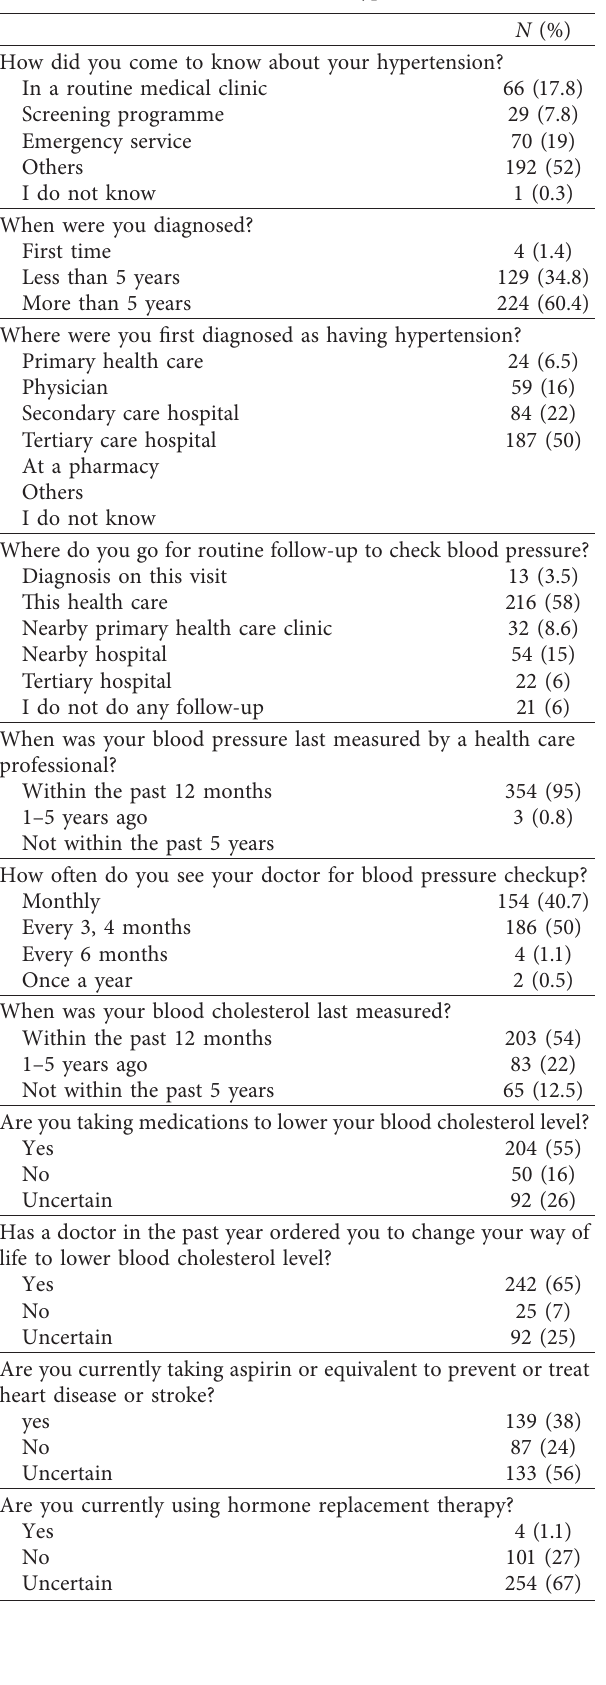
Table 2: KAP related to